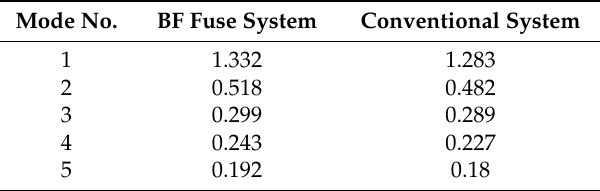
Table 2. Comparison of the periods of EBF building with BF fuse building